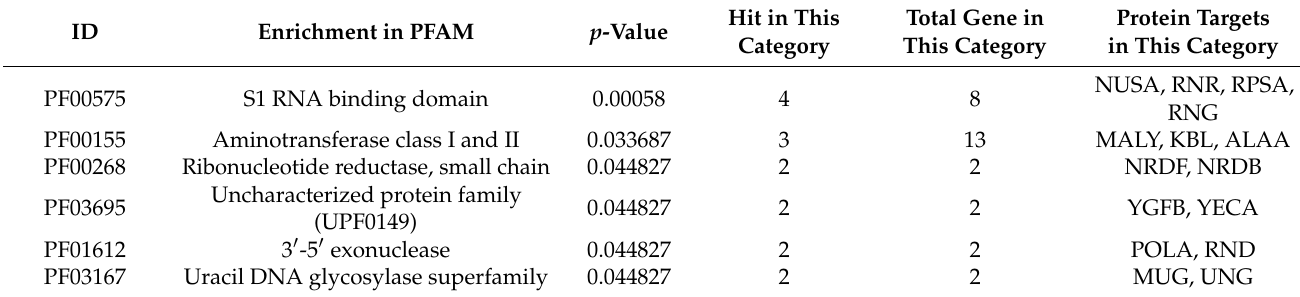
Table 4. Enrichment categories in protein families (PFAM) domain for the protein targets of polyphemusin-I.